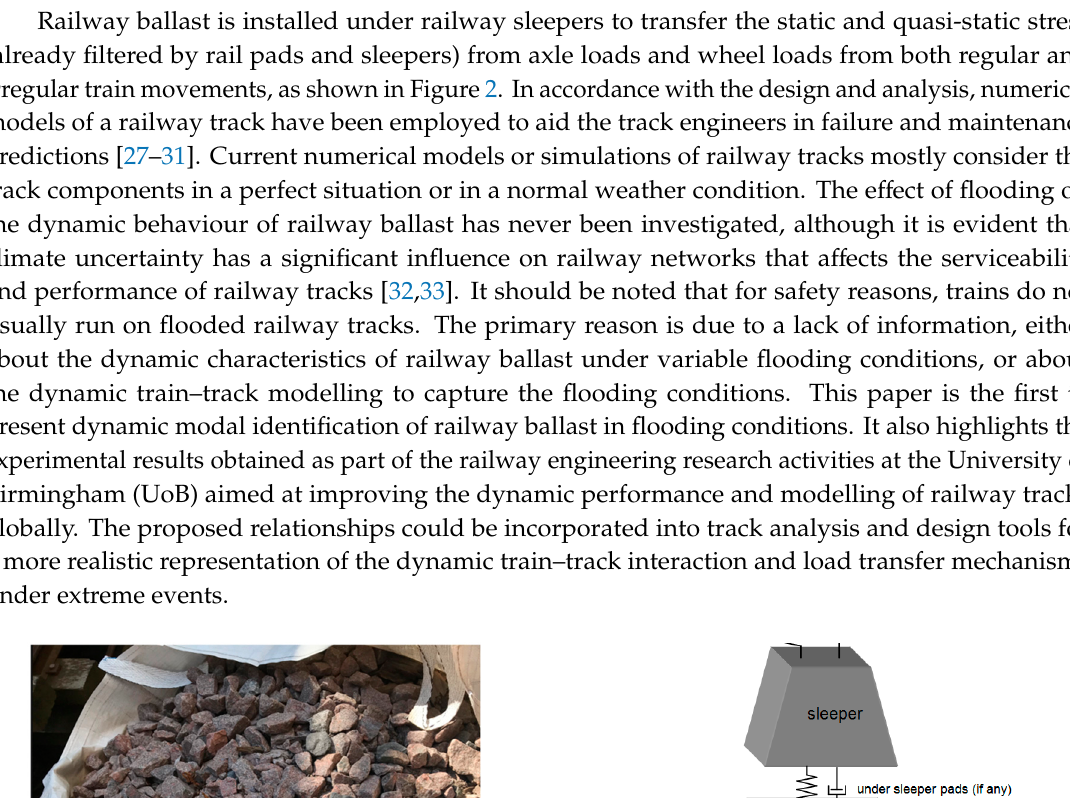
Table 1. Different types of mass .